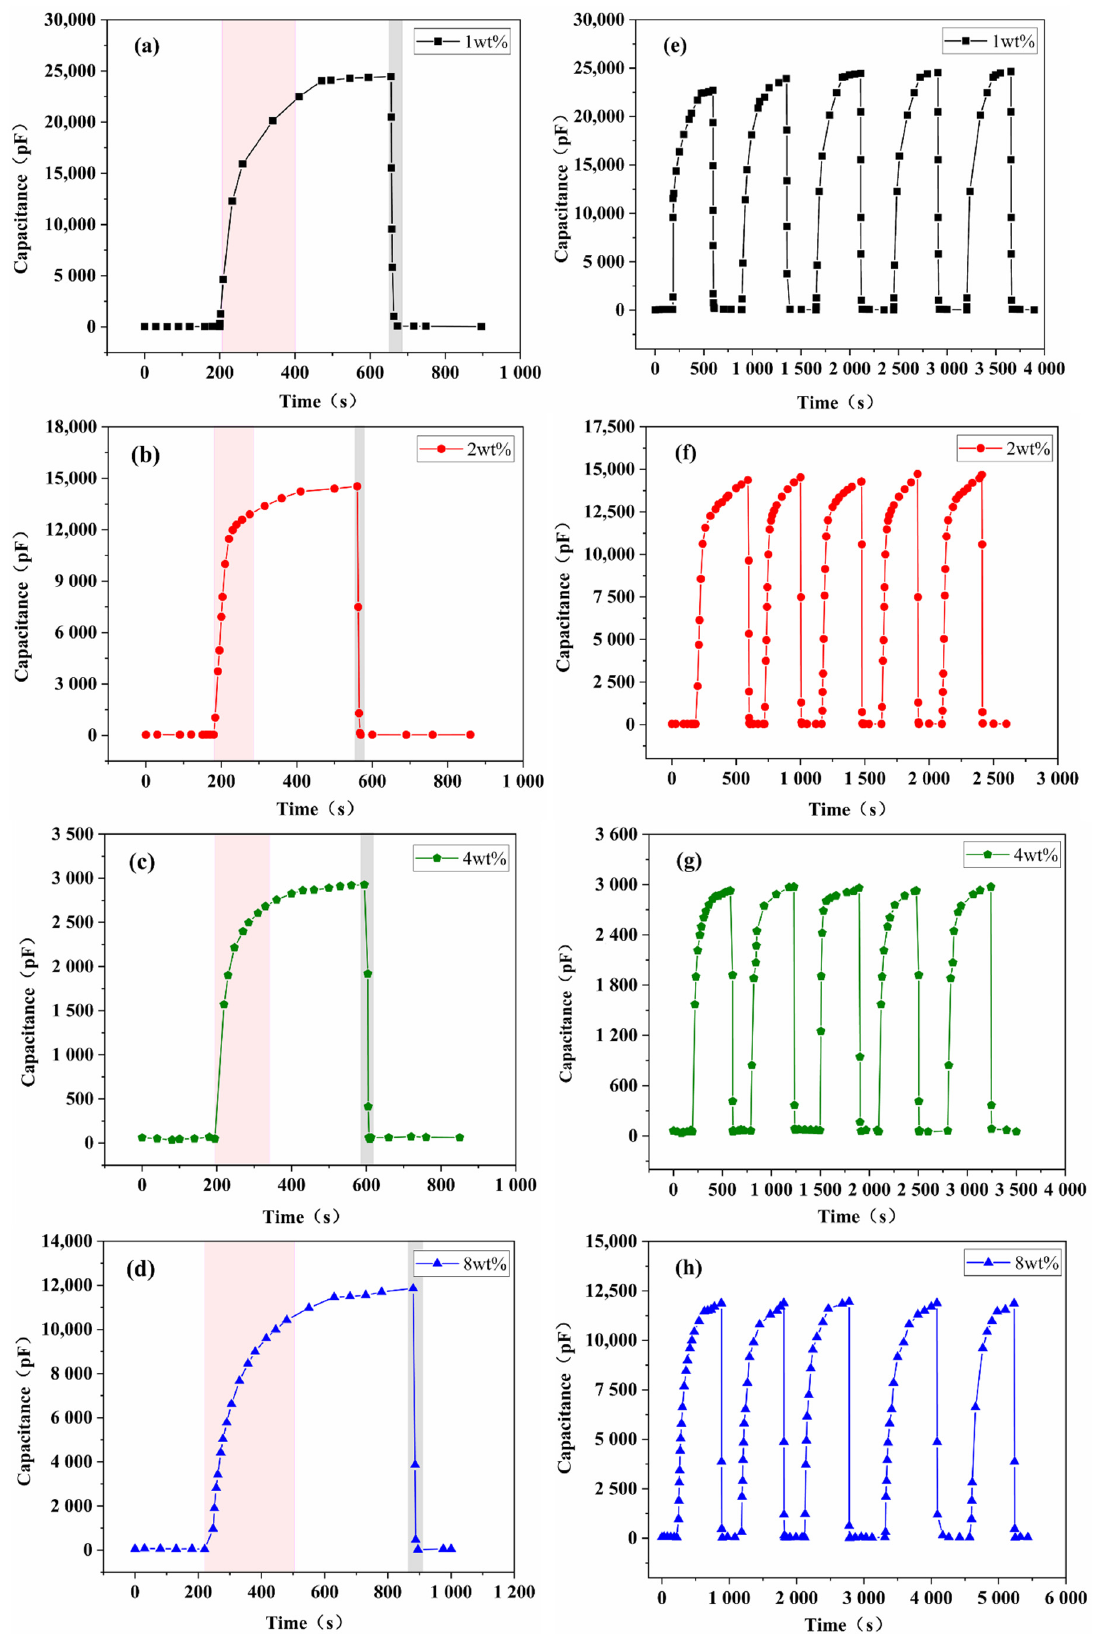
Figure 8. Response/recovery time and repeatability of SnO 2 /rGO sensor exposed to 95%RH from 11%RH with different doping ratios. ( a , e ) 1 wt%, ( b , f ) 2 wt%, ( c , g ) 4 wt%, and ( d , h ) 8 wt%.